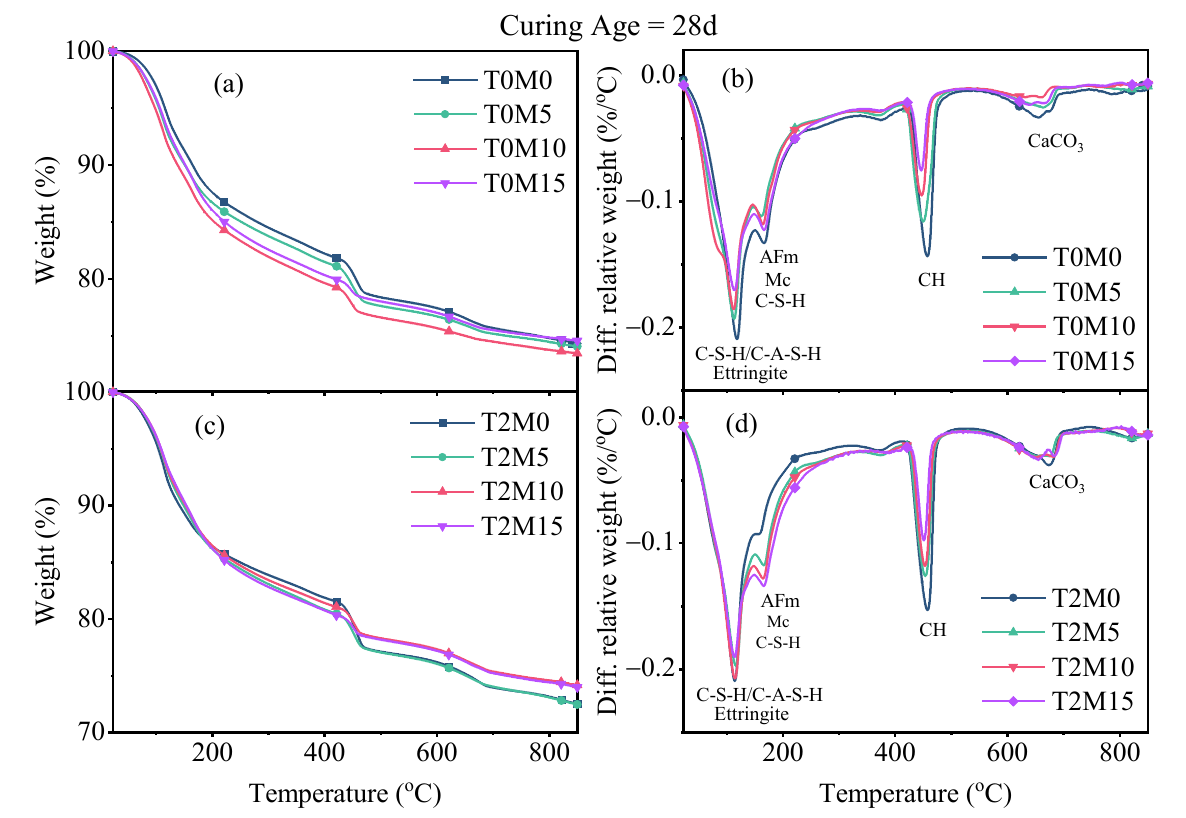
Figure 7. TGA results of the produced MK blended pastes with BTE after 28 days of sealed